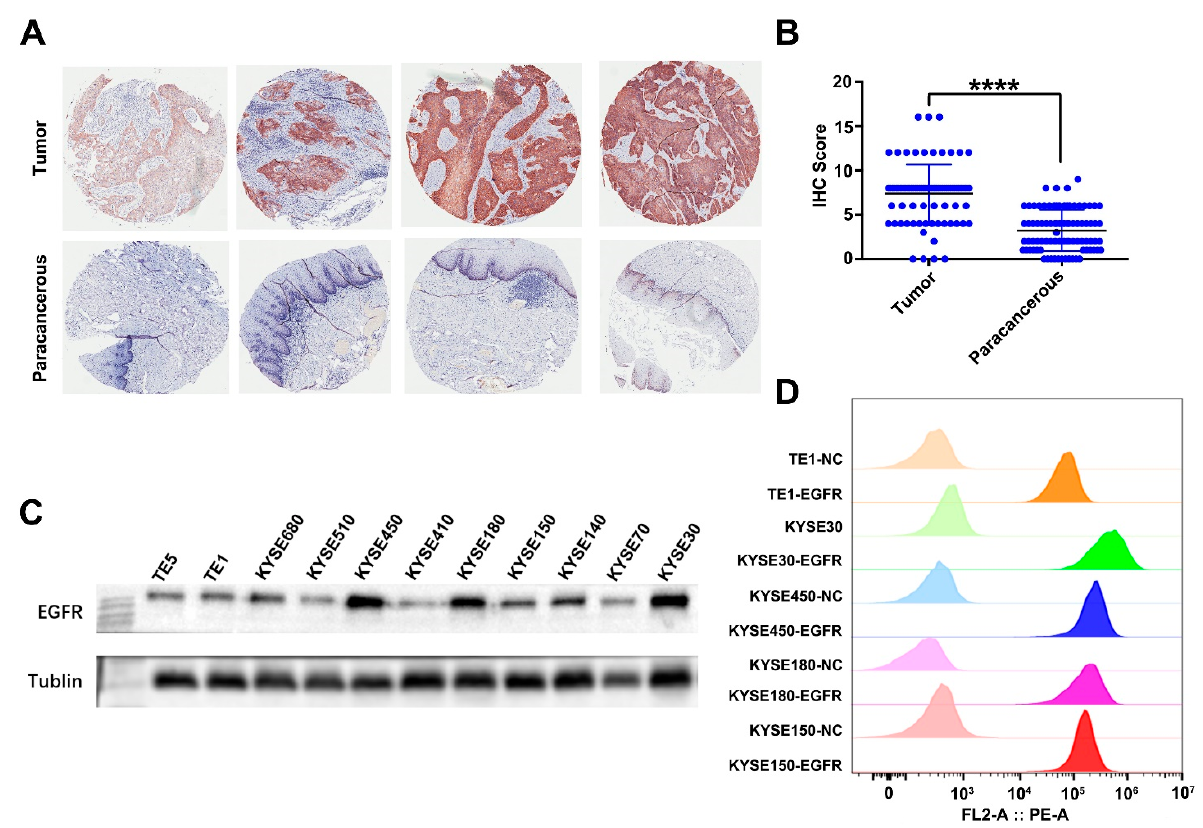
Figure 2. EGFR expression in ESCC tumor and paracancerous samples, and ESCC cell lines. ( A ) The expression of EGFR in ESCC tumor and paracancerou samples was detected by IHC. ( B ) The IHC score of EGFR of 85 ESCC tumor samples and paired paracancer samples. EGFR expression in ESCC cell lines TE1, KYSE30, KYSE450, KYSE180, and KYSE150 was analyzed by ( C ) Western blotting and ( D ) flow cytometry. Unpaired multiple two-tailed t -test. **** p < 0.0001.